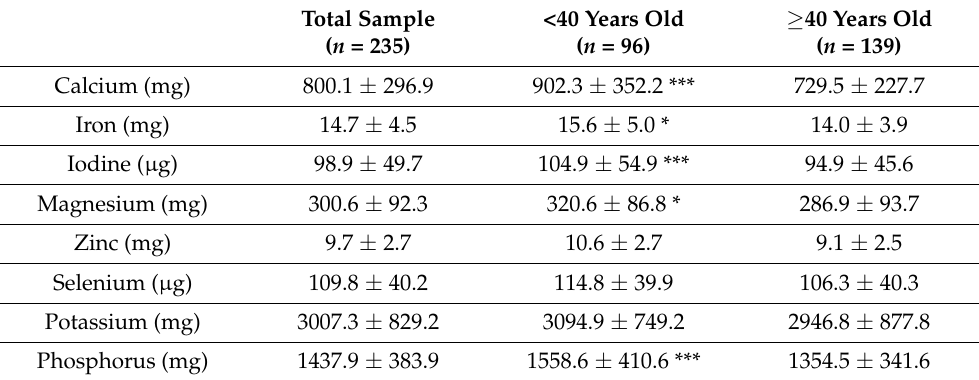
Table 5. Daily minerals intake of the total sample and sorted by age group.